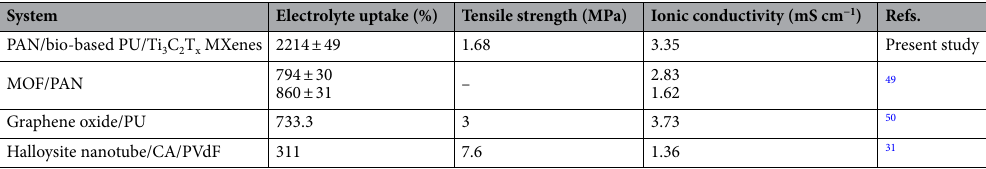
Table 2. Review of electrospun composite separator for metal ion batteries.